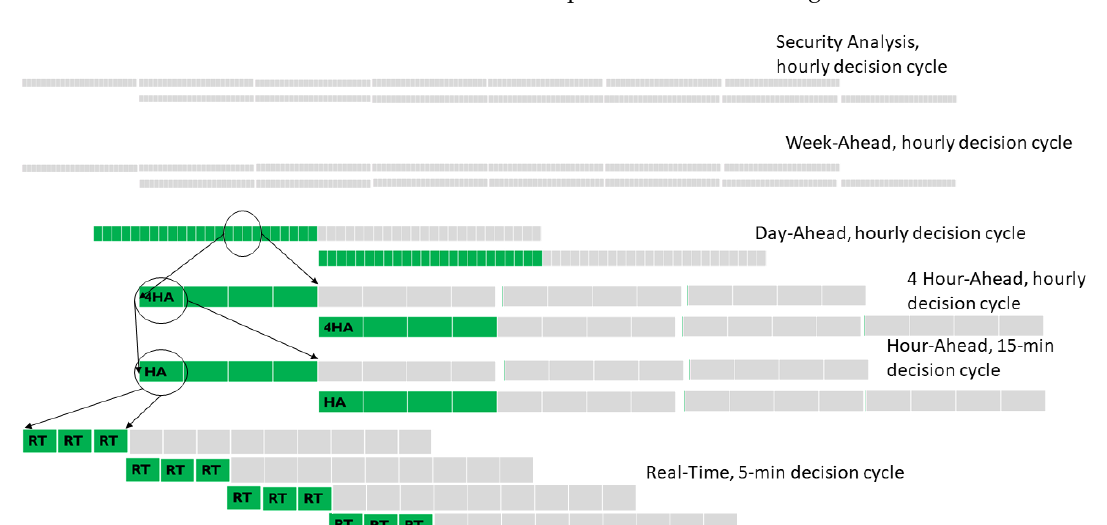
Figure 2. Multicycle rolling horizon modeling implemented in this study.